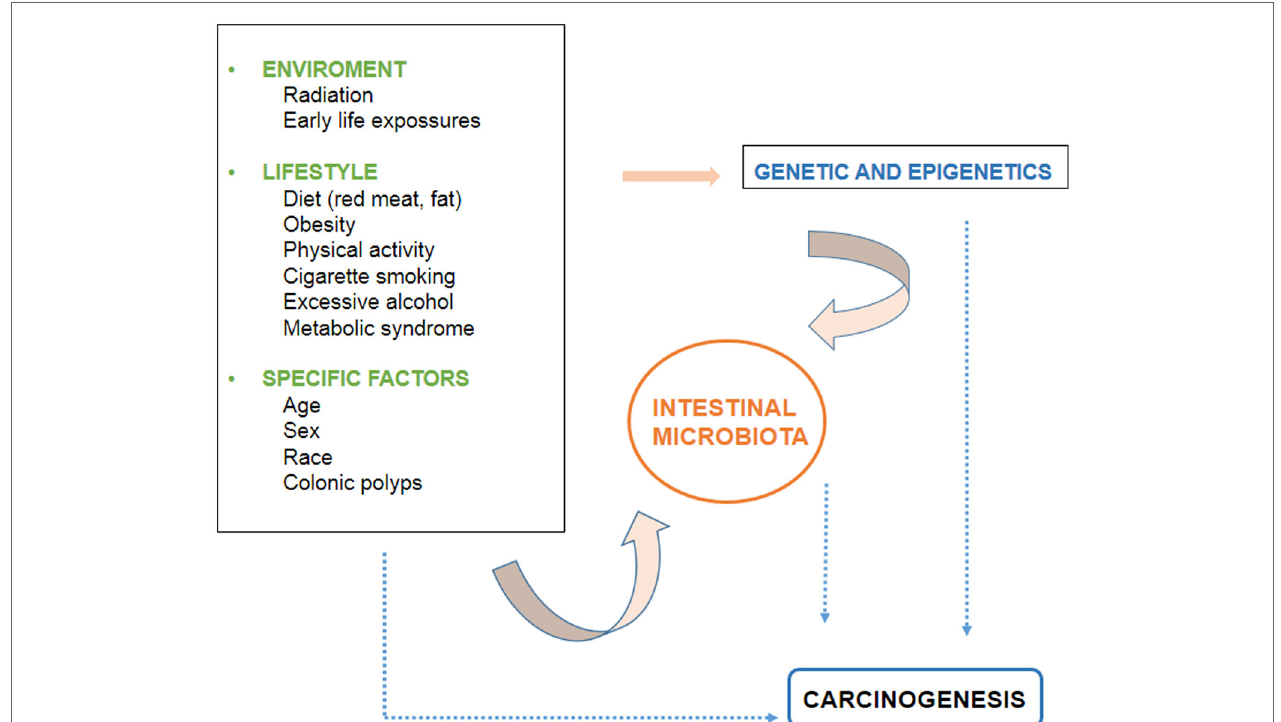
FiGURe 1 | Factors involved in the development of colorectal cancer